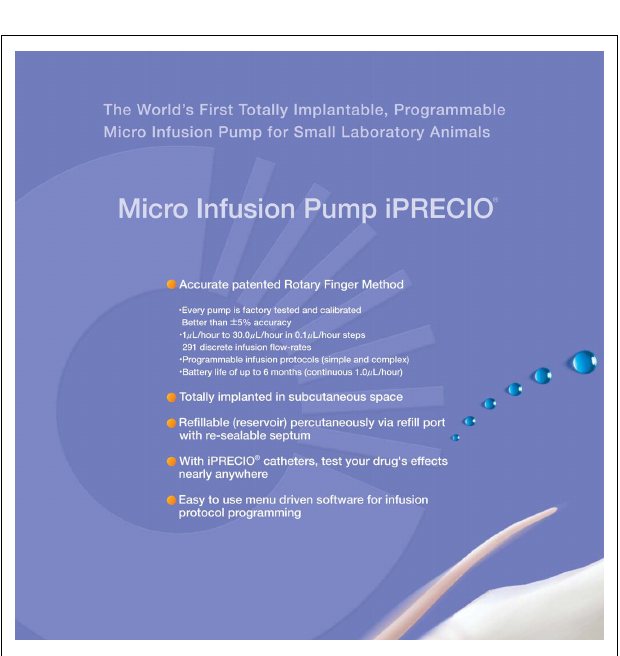
FIGURE 2 | Summary of the key features of the 2nd generation iPRECIO ® Pumps reproduced from the current SMP-200 product brochure.